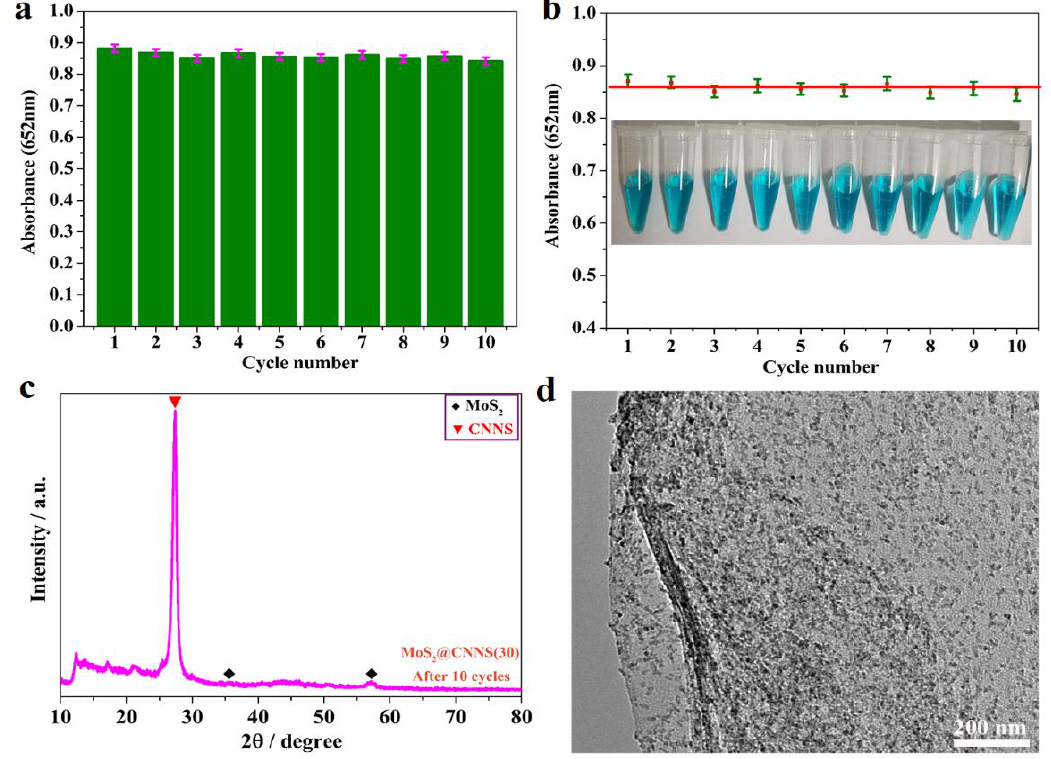
Figure 8. Stability and reusability experiments of MoS 2 @CNNS(30)-based assay system containing 120 µ g/mL MoS 2 @CNNS(30), 25.0 mM PBS (pH = 4.0), 2.0 mM H 2 O 2 , and 0.8 mM TMB ( a ), ( b ); XRD pattern ( c ) and TEM image ( d ) of MoS 2 @CNNS(30) after 10 cycles. Inset: related color changes in 10 cycles.